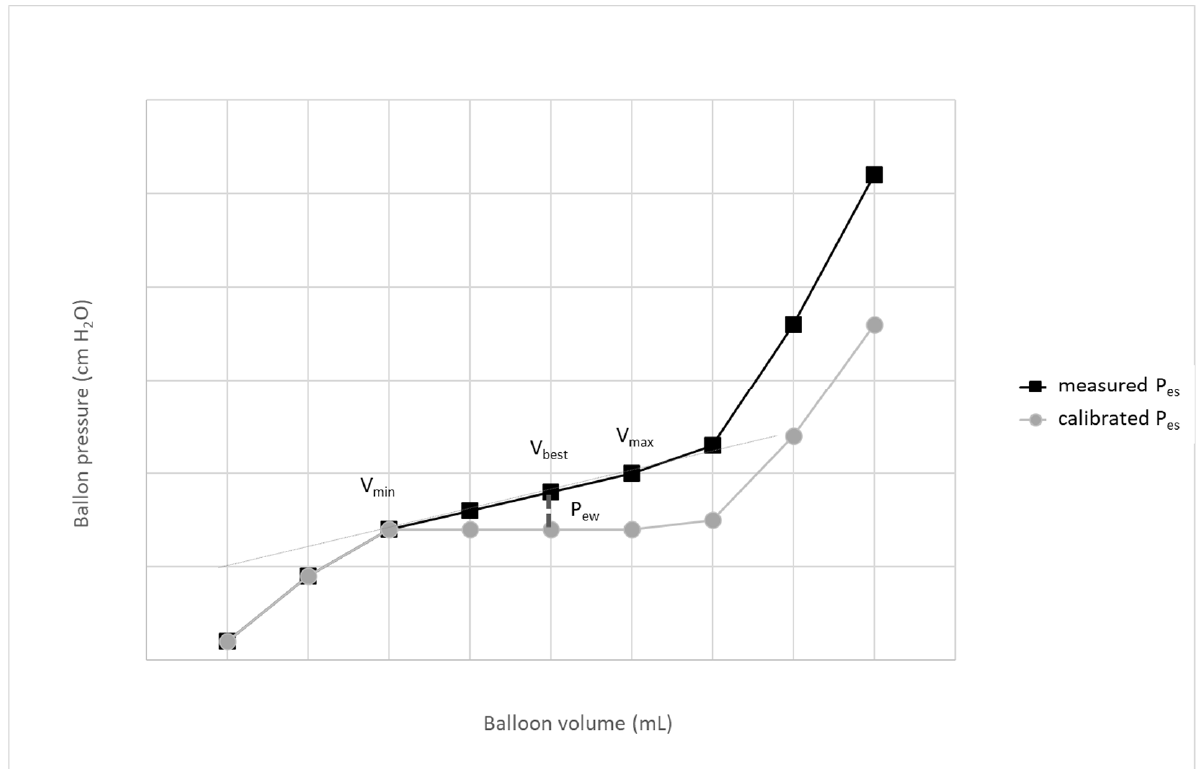
Figure 2. Effect of correction of esophageal elastance. A simplified scheme; expiratory P es values are shown only . P ew —pressure generated by the distension of esophageal wall; V min –volume of the balloon at the beginning of the linear part of the balloon pressure-volume curve; V max —volume of the balloon at the beginning of the linear part of the balloon pressure-volume curve.